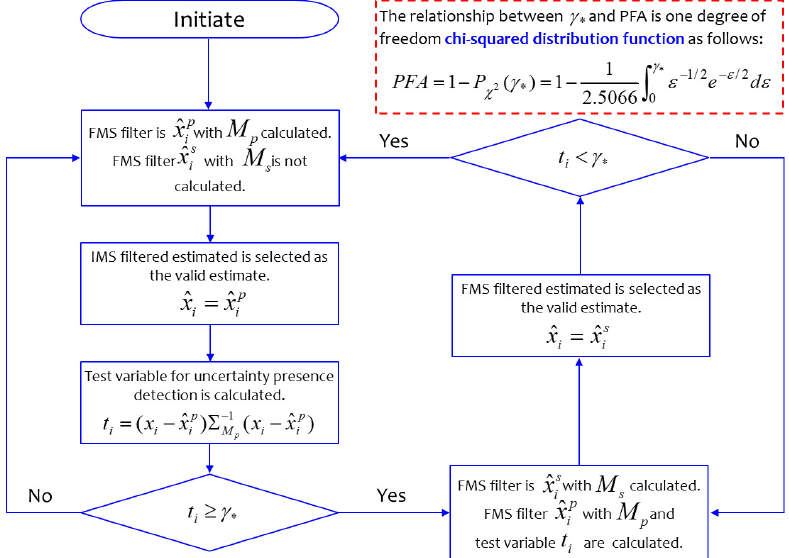
Figure 1. Operation flow for the proposed selective finite memory structure (FMS) filtering. False alarm